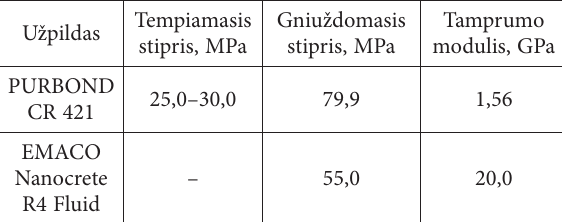
Fig. 8. Beam’s collapse while splitting timber along